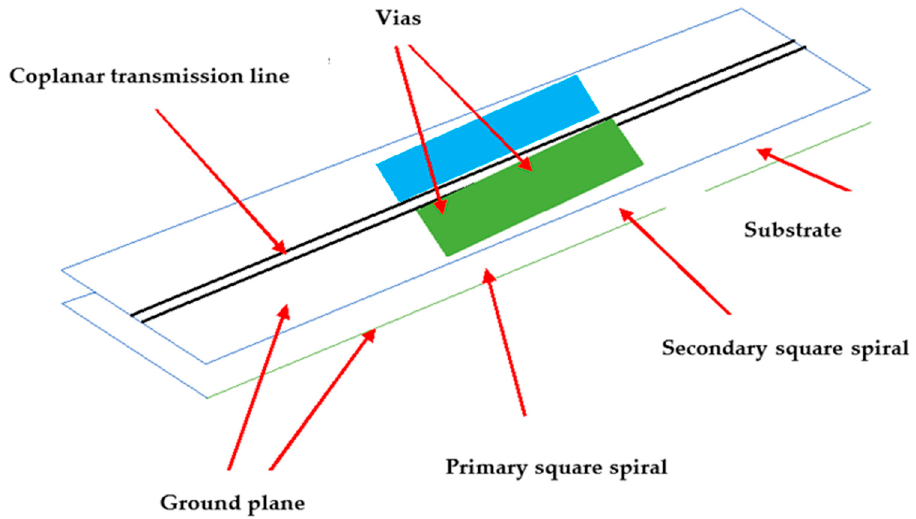
Figure 7. simple coupled spiral inductor sensor. Figure 7. Simple coupled spiral inductor